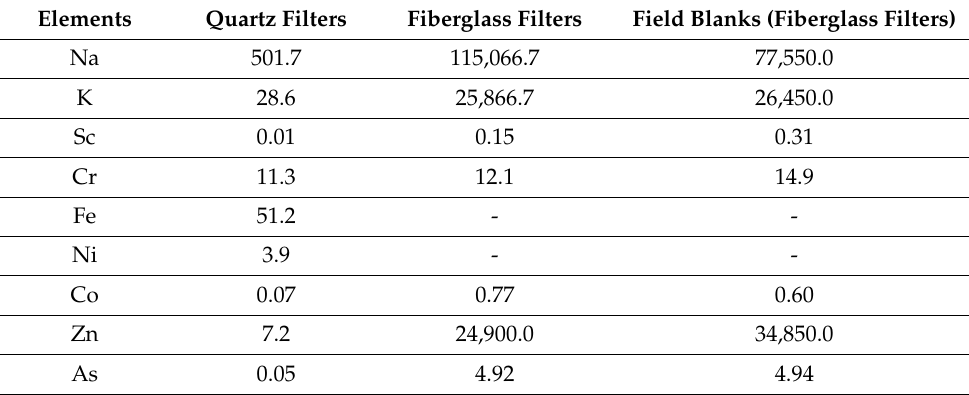
Table 4. The mass fractions [mg/kg] of elements determined from the filters made of quartz or glass fibers. The field blank, unlike the other filters, undergoes the entire process of a sample, except it is not exposed to the sampling